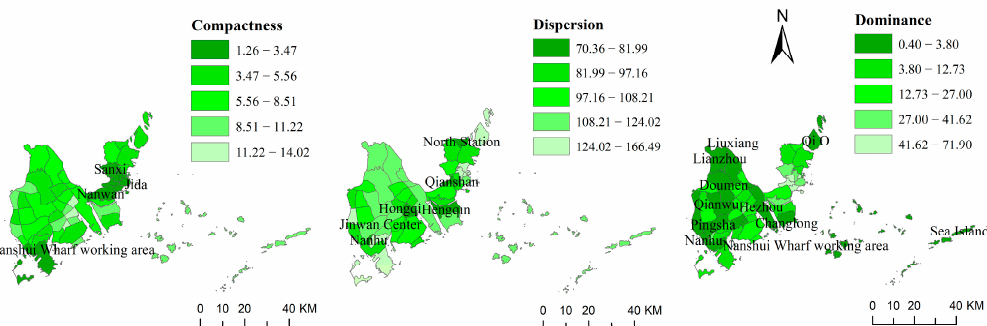
Figure 7. Spatial distribution of negative independent variables in Zhuhai.